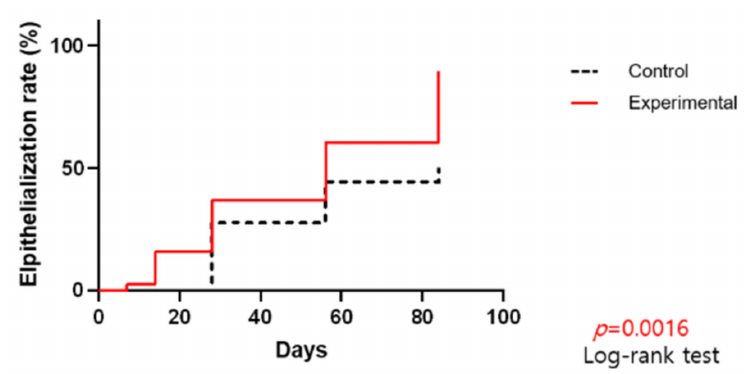
Figure 4. Wound epithelization rate by day.